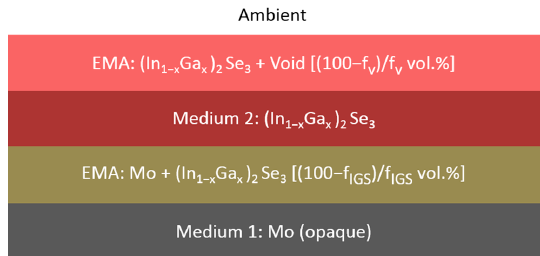
Figure 3. Three-layer structural model used for the analysis of RTSE data acquired in the later stages of the depositions for IGS thin films prepared under conditions that simulate the stage I process of roughness on the uncoated Mo film are completely filled by the deposited IGS material.